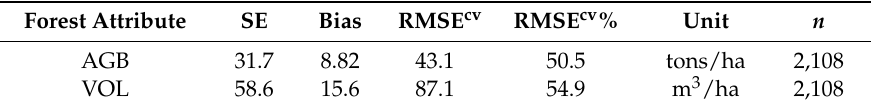
Table 2. Model estimation statistics including results from residual modelling errors SE and leave-one-out cross-validation RMSE cv . n denotes the number of plots.